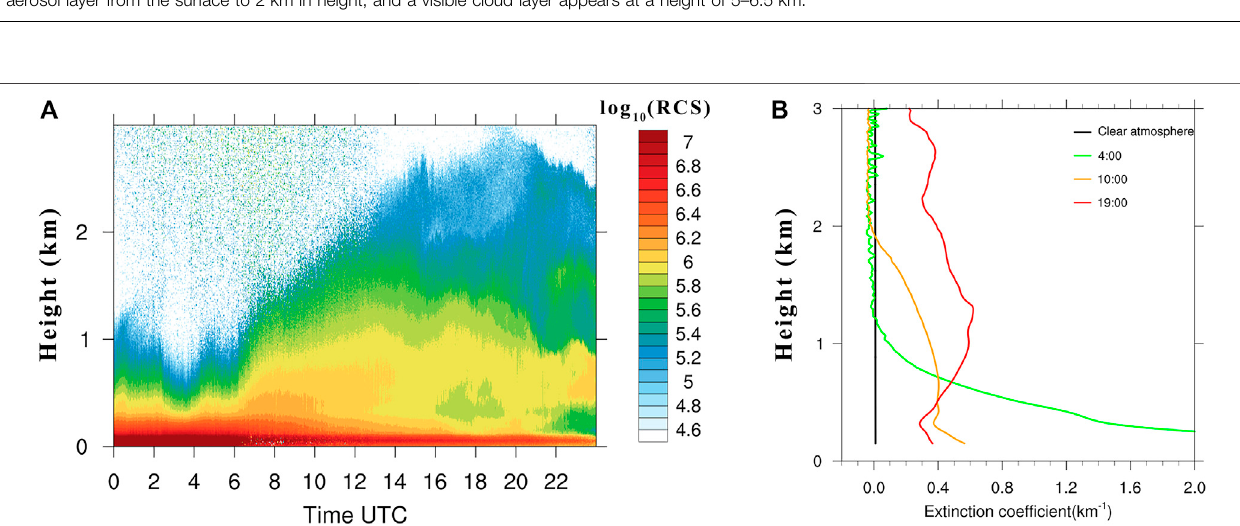
FIGURE6|(A) Diurnalvariationoflog 10 (RCS)oftheceilometeronJuly26,2019. (B) Verticalpro fi lesofaerosolextinctioncoef fi cient(km − 1 )atvarioushoursonJuly 26, 2019. A distinct dust aerosol layer is lofted from 06:00 UTC. The black line illustrates the Rayleigh extinction coef fi cient of air molecules.